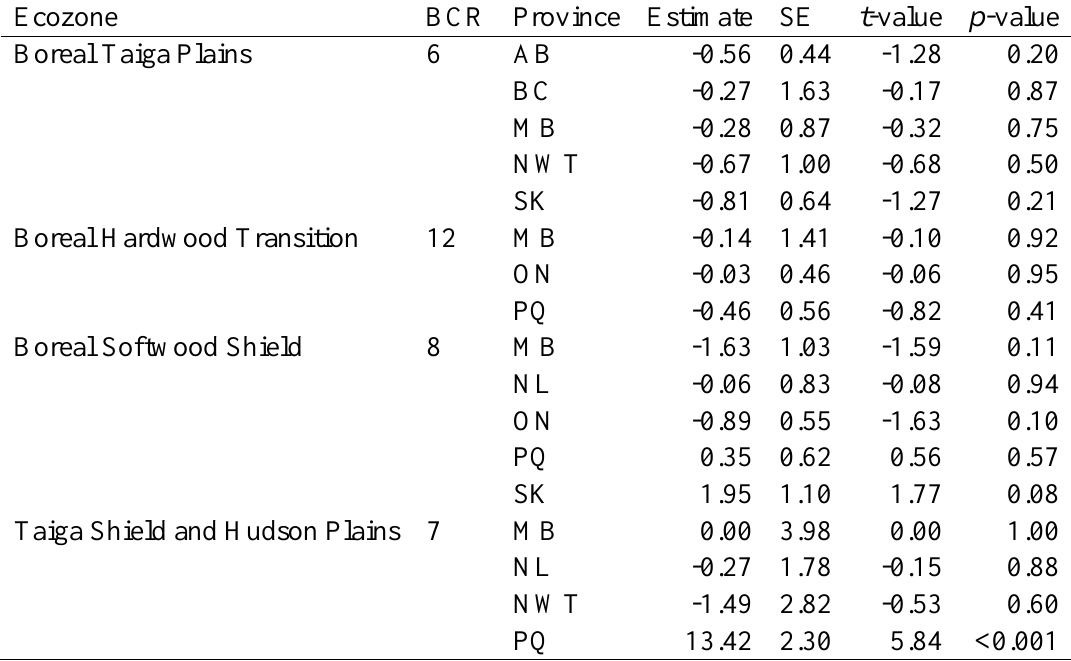
Table A1.2 Results of GAMM for bias in measurement of forest fire based on GIS analysis of 20 buffer distances between 25 – 1500m along 455 BBS routes